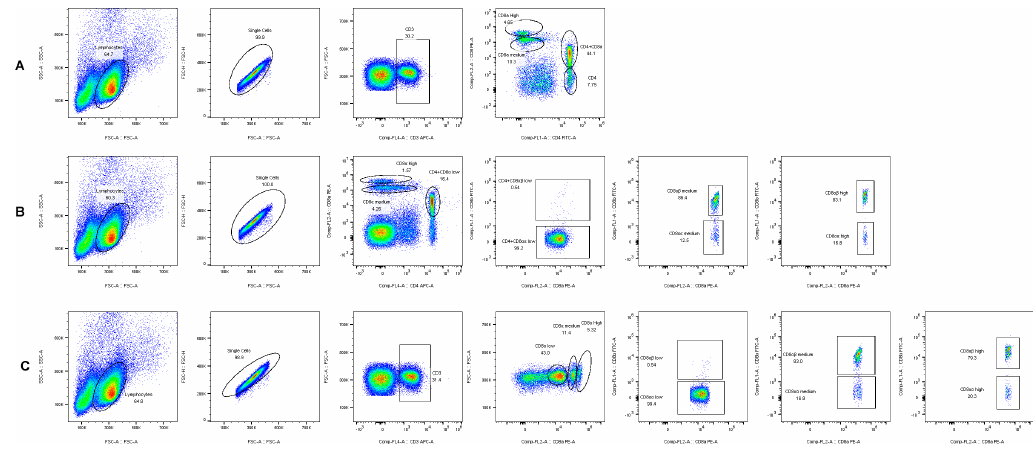
Figure 7. CD8 + T cell phenotype identification in PBL of ALV-J infected chicken number 12. ( A ) Gating strategy for analysis of CD8 high α + , CD8 medium α + , CD4 + , and CD4 + CD8 low α + T cells with the CD3 + (APC), CD4 + (FITC), and CD8 α + (PE) antibodies. ( B ) Gating strategy for analysis of CD8 + αα and CD8 + αβ phenotype in three CD8 + populations with the CD4 + (APC), CD8 β + (FITC), and CD8 α + (PE) antibodies. ( C ) Gating strategy for analysis of CD8 + αα and CD8 + αβ phenotype in three CD8 + populations with the CD3 + (APC), CD8 β + (FITC), and CD8 α + (PE) antibodies. Each dot indicated each collected cell. And the circle or fame indicated the gated target cell population labelled by various antibodies. Each sample collected 1 × 10 5 cells for flow cytometric analysis.